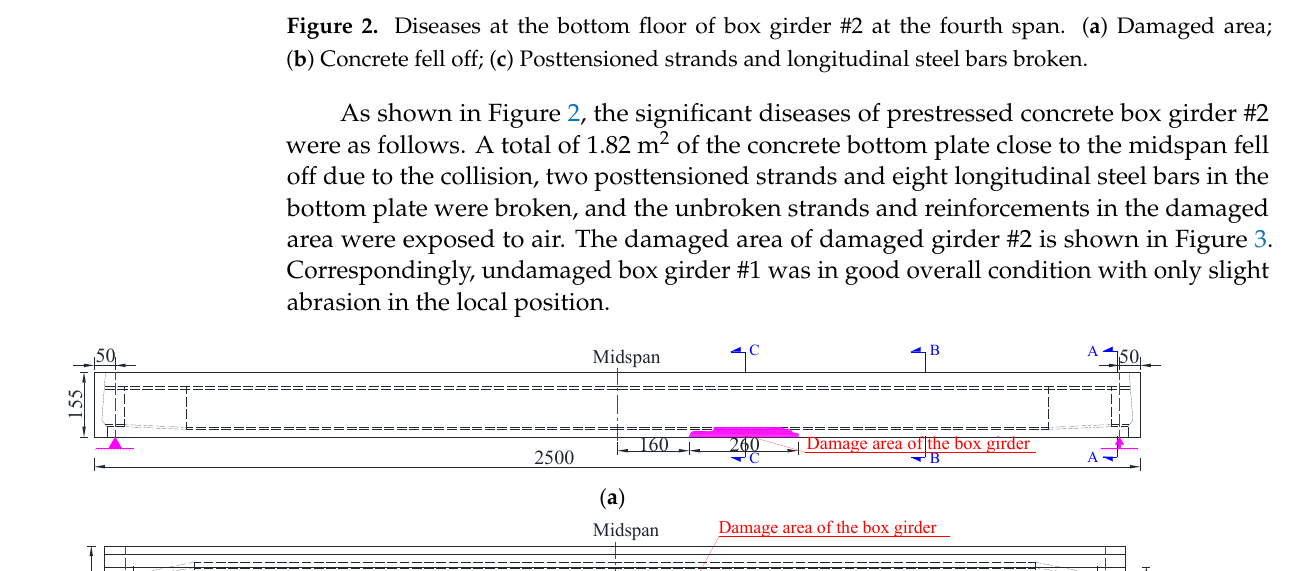
Figure 2. Diseases at the bottom floor of box girder #2 at the fourth span. ( a ) Damaged area; ( b ) Concrete fell off; ( c ) Posttensioned strands and longitudinal steel bars broken.